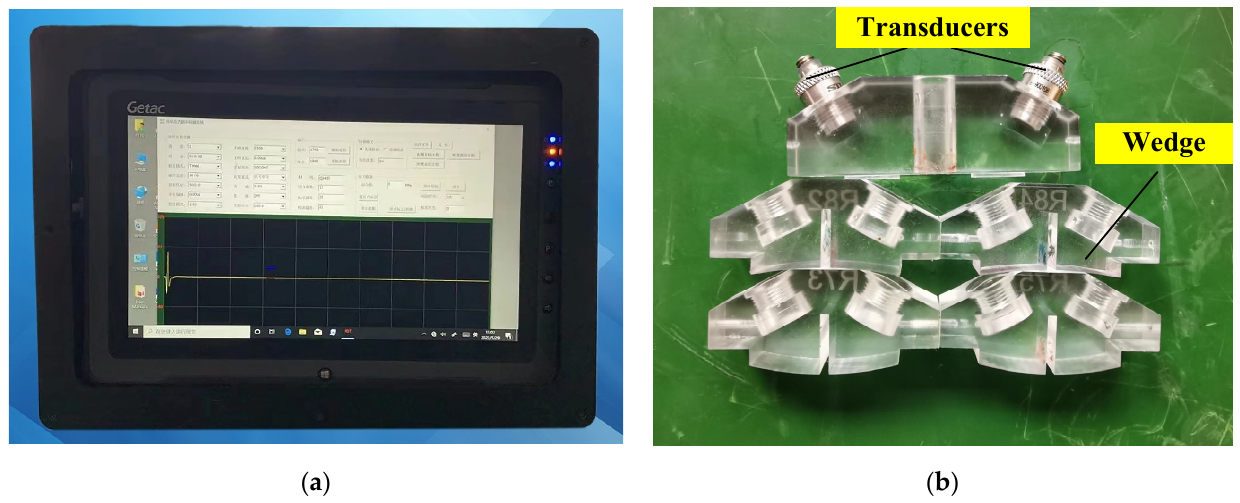
Figure 1. Wave propagation path of ultrasonic testing: ( a ) Residual stress detector; ( b ) Wedge. According to GB/T 32073-2015, tensile samples for calibration of the stress coefficient K were produced. A WDW-200E microcomputer-controlled electronic universal testing